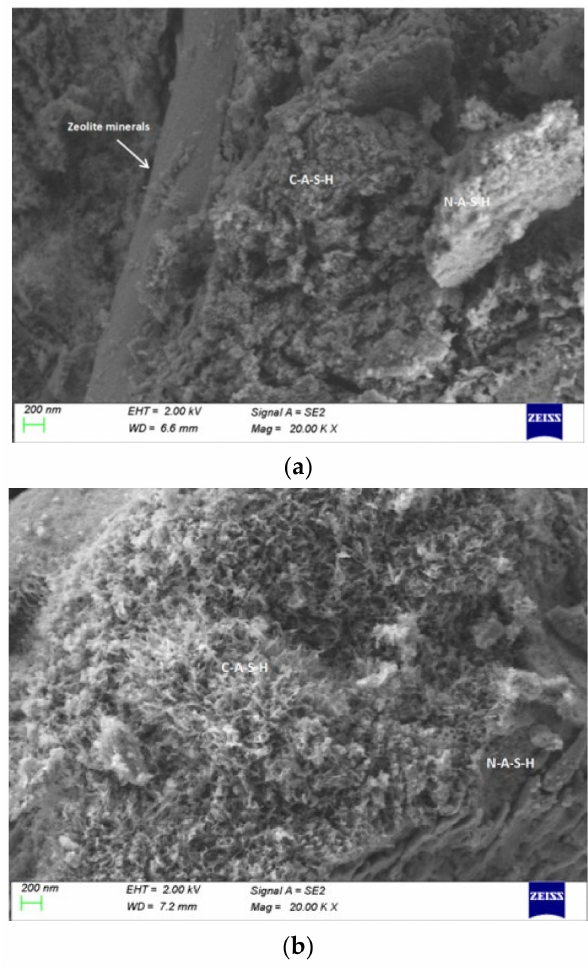
Figure 14. SEM images of geopolymers. ( a ) SS14 ( b )